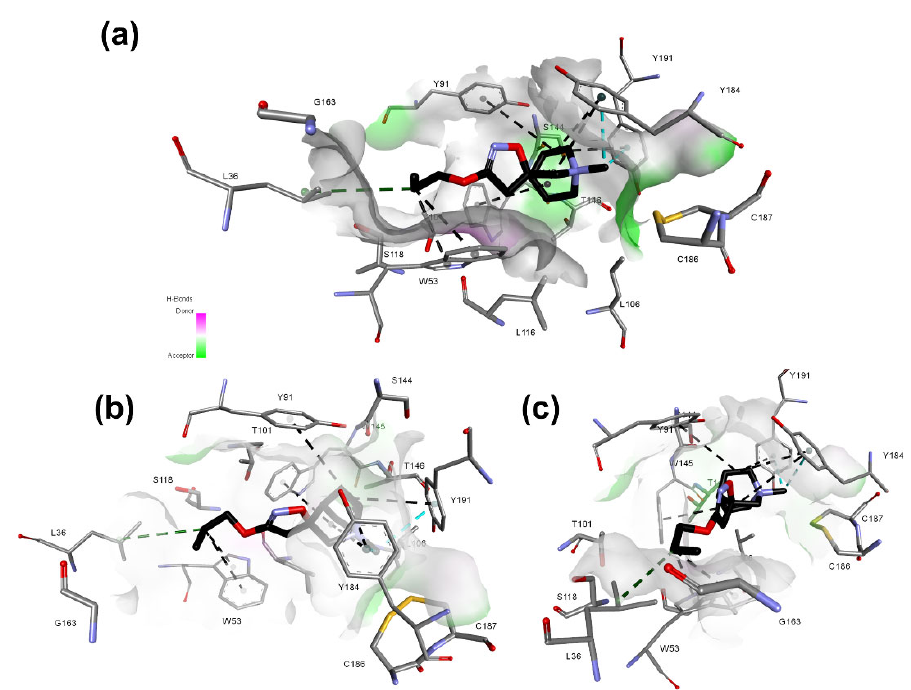
Figure 11. Best docking pose of 20 and hydrogen bond potential surface of α 7 receptor binding pocket. Nitrogen atoms are shown in blue, sulfur in yellow, oxygen atoms in red, hydrogen atoms were omitted for clarity and carbon atoms in gray (amino acids) or black (ligand). Molecular interactions are shown as dotted lines: alkyl-alkyl in green, π -sigma in cyan, and π -alkyl in black. ( a – c ) correspond to different site views.